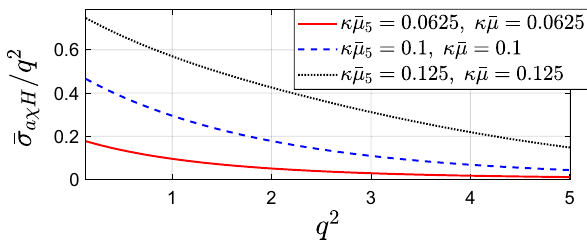
Fig. 12 q 2 -dependence of ¯ σ a χ H when ω = 0